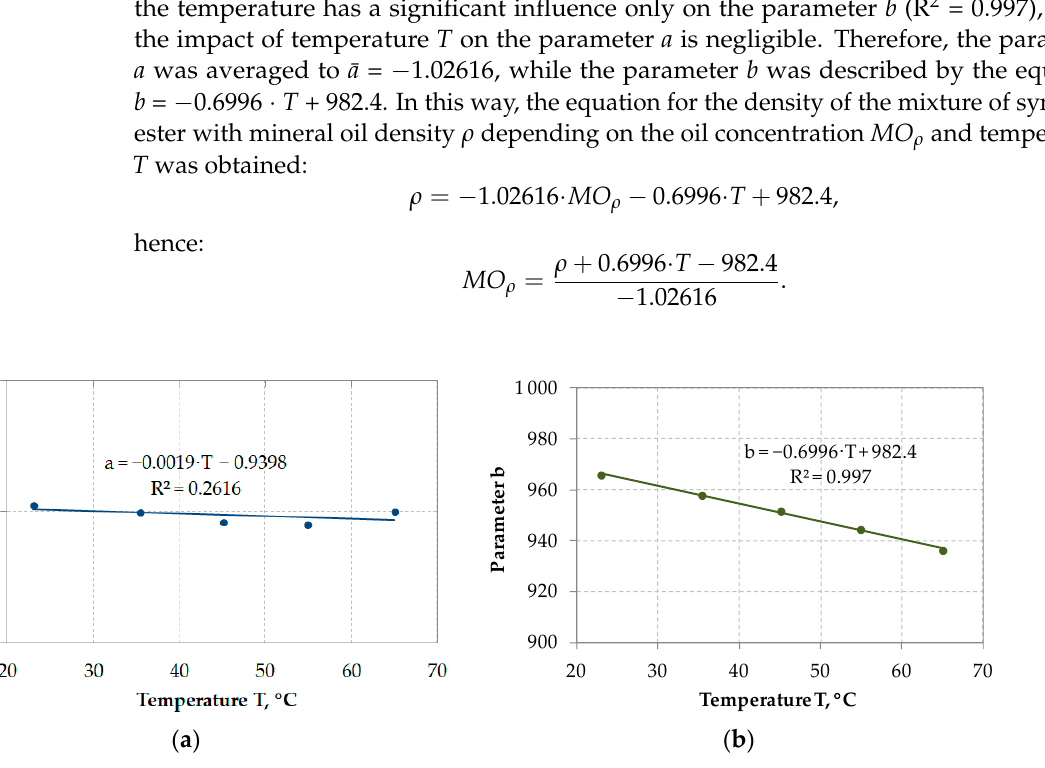
( b ) Figure 5. Differences between the real and calculated values of the mineral oil concentration in its mixture with the syn- thetic ester Δ MO ρ 1 ( a ) and the absolute values of the largest differences for all temperature values ⏐ Δ MO ρ 1 ⏐ ( b ). The charts show that the greatest difference between real and calculated values does not exceed 1.5%. This value can be taken as the first component of the uncertainty.